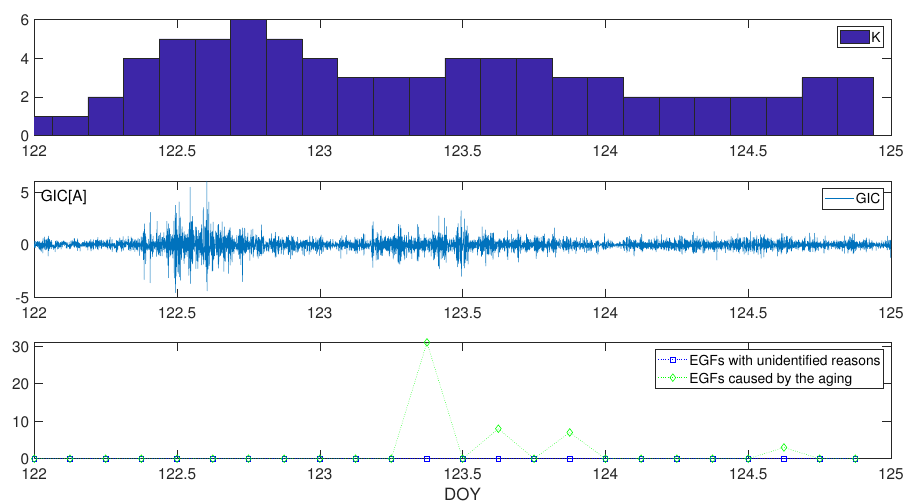
Figure 3. K index from Belsk (3-h resolution), computed geomagnetically induced currents (1-min resolution) and electrical grids failures (EGFs) (3-h resolution) around 2 May 2010 (122 doy). On the horizontal axis is marked the day-of-year.